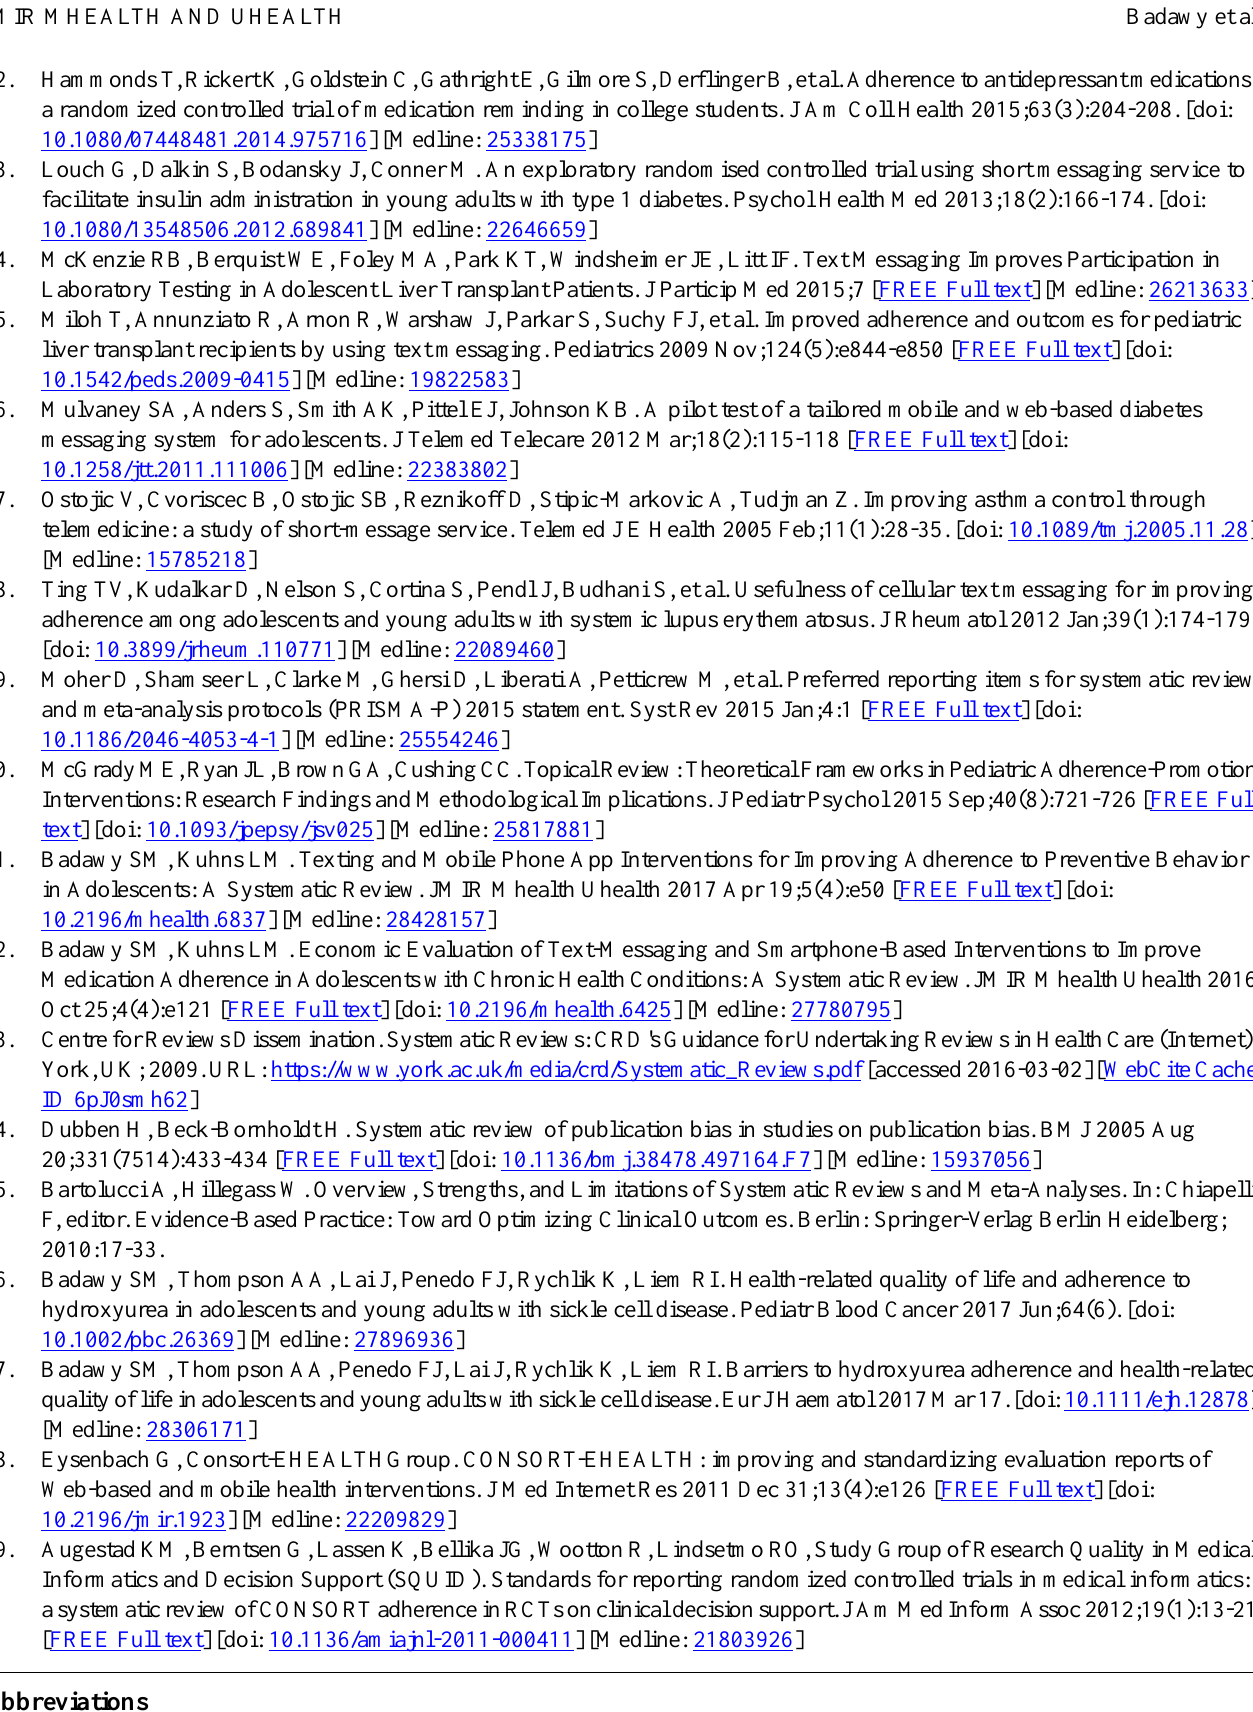
Abbreviations CHCs: chronic health conditions GRADE: Grades of Recommendation, Assessment, Development, and Evaluation HRQOL: health-related quality of